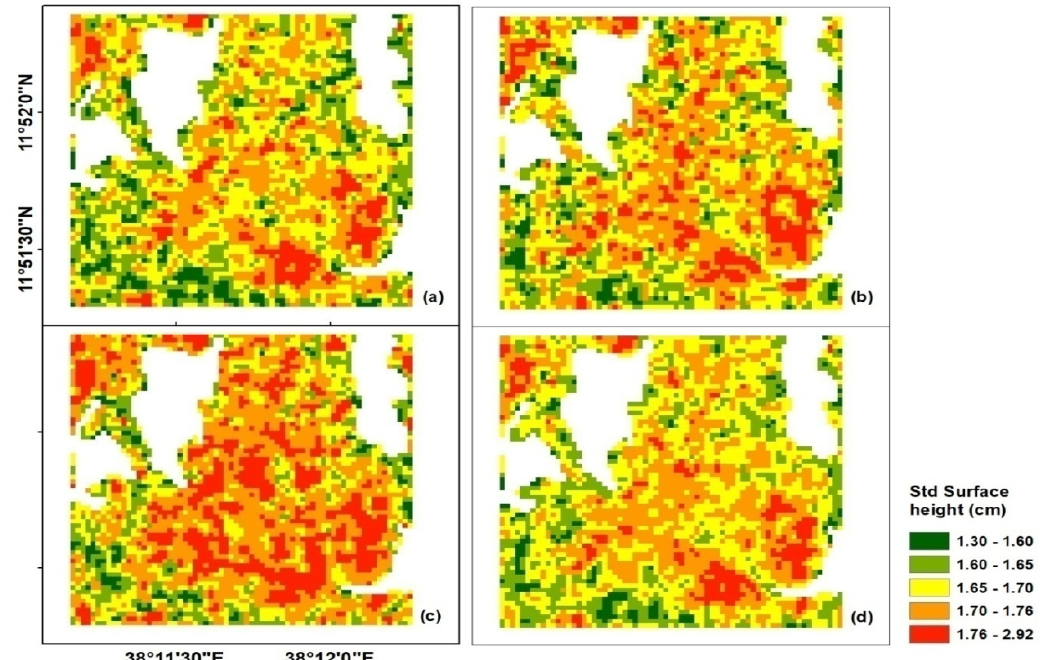
Figure 7. The standard deviation of surface heights ( ℎ (cid:3045)(cid:3040)(cid:3046) ) : ( a ) November 22, 2016, ( b ) December 16, 2016, ( c ) February 02, 2017, and ( d ) the average ℎ (cid:3045)(cid:3040)(cid:3046) calculated from ( a ) and ( b ).